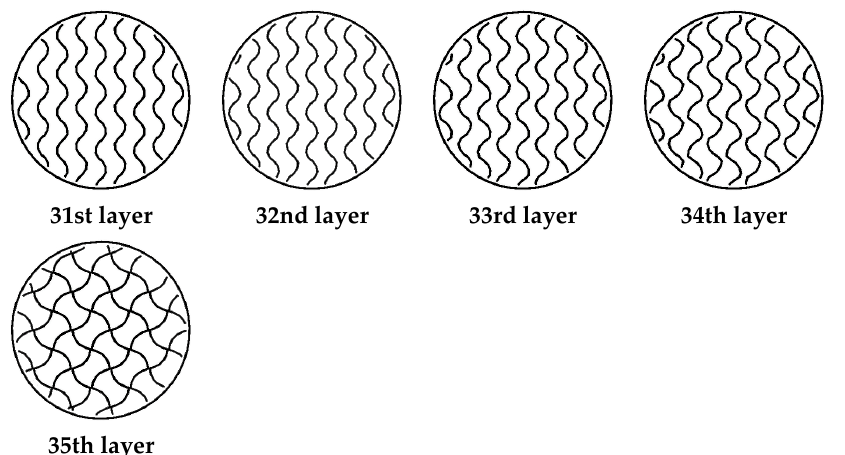
Figure A1. Tracing pattern in each layer of a 36% gyroid fill in a complete cycle from the 7 th layer to the 35 th layer.